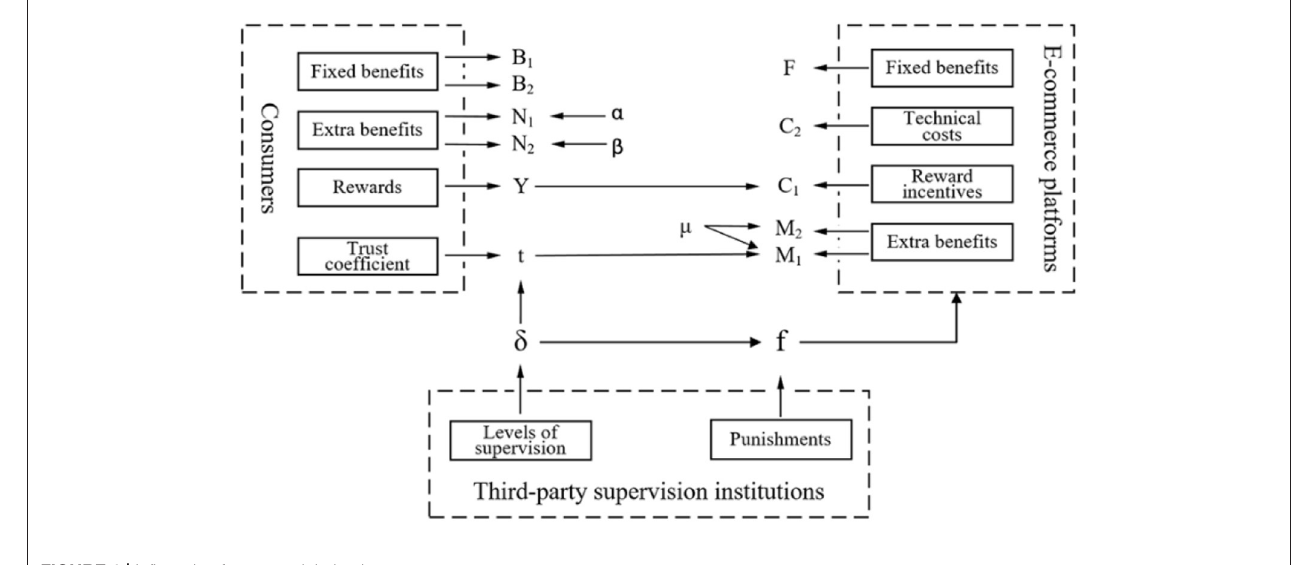
FIGURE 1 | Influencing factors and their